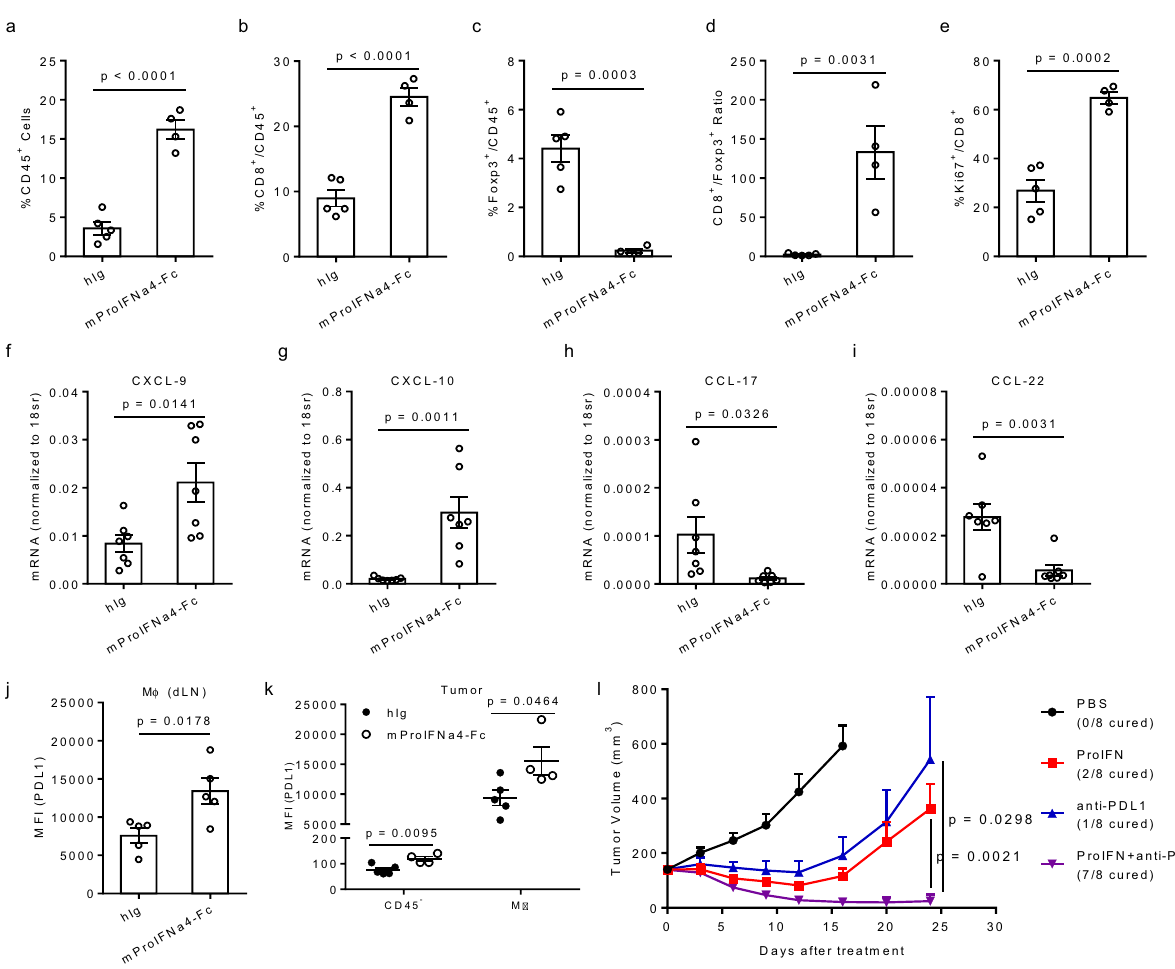
Fig. 5 Checkpoint blockage bene fi ts from ProIFN-optimized tumor microenvironment. a – e C57BL/6 J mice were s.c. inoculated with 5 × 10 5 B16-OVA tumor cells and i.p. treated with 1 nmol of hIg, or mProIFNa4-Fc, on day 9, 12, and 15 ( n = 5 animals for hIg, n = 4 animals for mProIFNa4-Fc). 5 days after the last treatment, mice were euthanized. Tumors and draining lymph nodes (dLNs) were extracted, digested in collagenase/DNase, and resuspended as single cells. Tumor-in fi ltrating T cells were analyzed via fl ow cytometry for the frequency of total CD45 + cells ( a ), CD8 + T cells ( b ), Foxp3 + T cells ( c ), CD8 + /Foxp3 + ratio ( d ), and Ki67 + CD8 + T cells ( e ). f – i C57BL/6 J mice were s.c. inoculated with 5 × 10 5 B16 cells and i.p. treated with 1 nmol of hIg or mProIFNa4-Fc on day 11 ( n = 7 animals). Tumor tissues were harvested 48 h after treatment. Intracellular RNA was extracted for RT-qPCR assay to determine expression levels of CXCL-9 ( f ), CXCL-10 ( g ), CCL-17 ( h ), and CCL-22 ( i ). j , k PD-L1 expression in tumors and draining lymph nodes (dLNs) from tumor-bearing mice in a was measured by fl ow cytometry. Mean fl uorescent intensities (MFIs) of PD-L1 staining in dLN ( j ) and tumor ( k ) were shown ( n = 5 animals). l Combination of mProIFNa4-Fc and a-PD-L1 antibody therapy. C57BL/6 J mice were s.c. inoculated with 1 × 10 6 MC38 tumor cells and i.p. treated with 1 nmol of mProIFNa4-Fc on day 12, 14, and 16 ( n = 8 animals). 200 μ g anti-PD-L1 was i.p. administrated on day 12, and 16. Tumor growth was shown. Data are reported as mean ± s.e.m. Two-tailed t -tests ( a – k ) or two-way ANOVA ( l ) were performed to calculate p -values. Source data are provided as a Source data fi